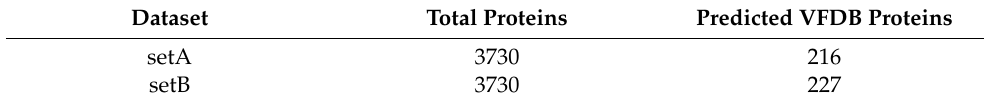
Table 1. Annotation of virulence factors of pathogenic bacteria (VFDB) database.